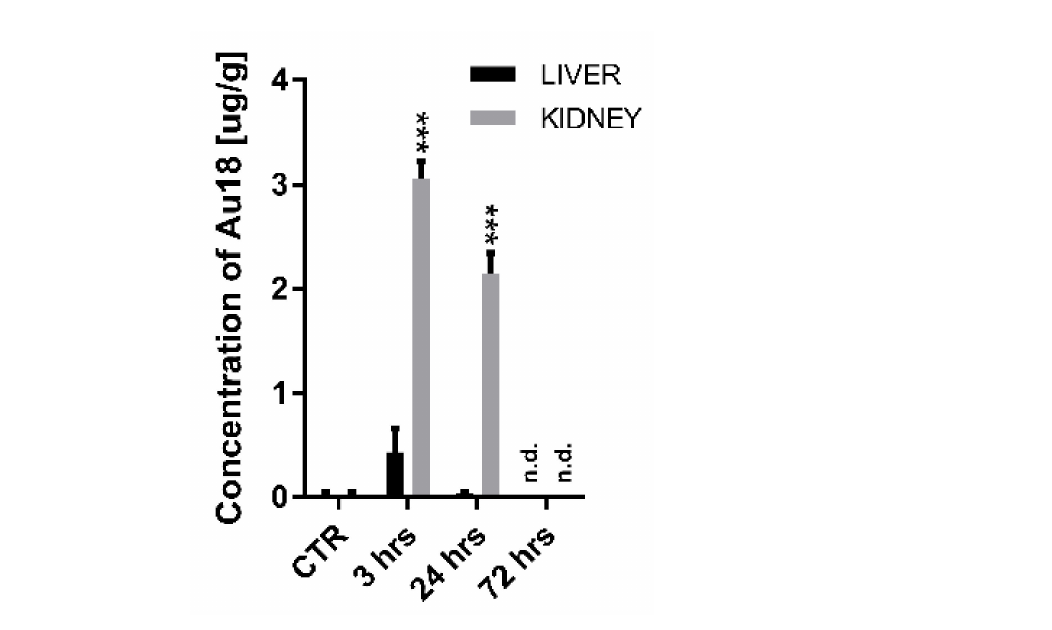
Figure 4. Biodistribution of Au18 NCs in mice. Au concentration measured with inductively coupled plasma optical emission spectrometer (ICP-OES) in non-treated control mice (CTR) and at 3, 24 and 72 h post intraperitoneal injections. Values are represented as mean ± SEM ( n = 3/time/organ, *** p < 0.001 as compared to negative control,